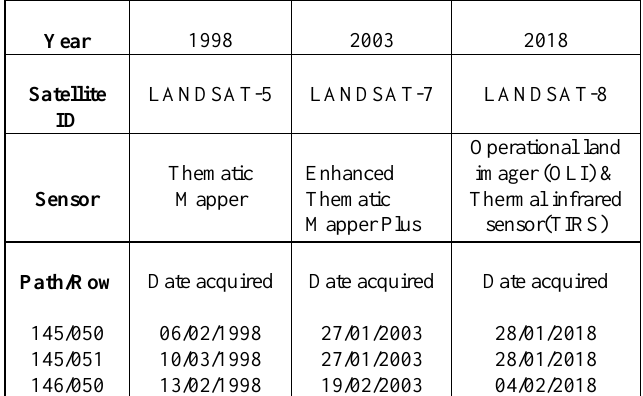
Table 8 Land use land cover